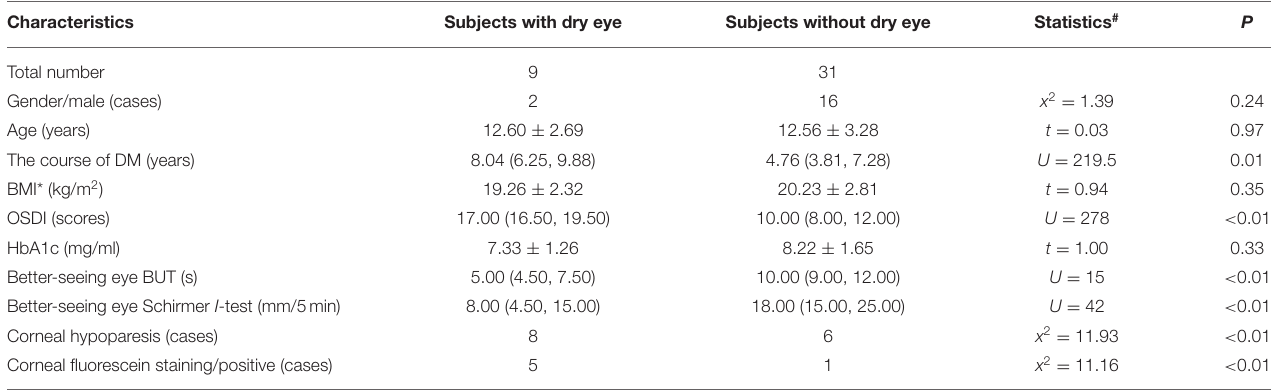
TABLE 1 | Characteristics and eye examination results of 40 children with DM. Characteristics